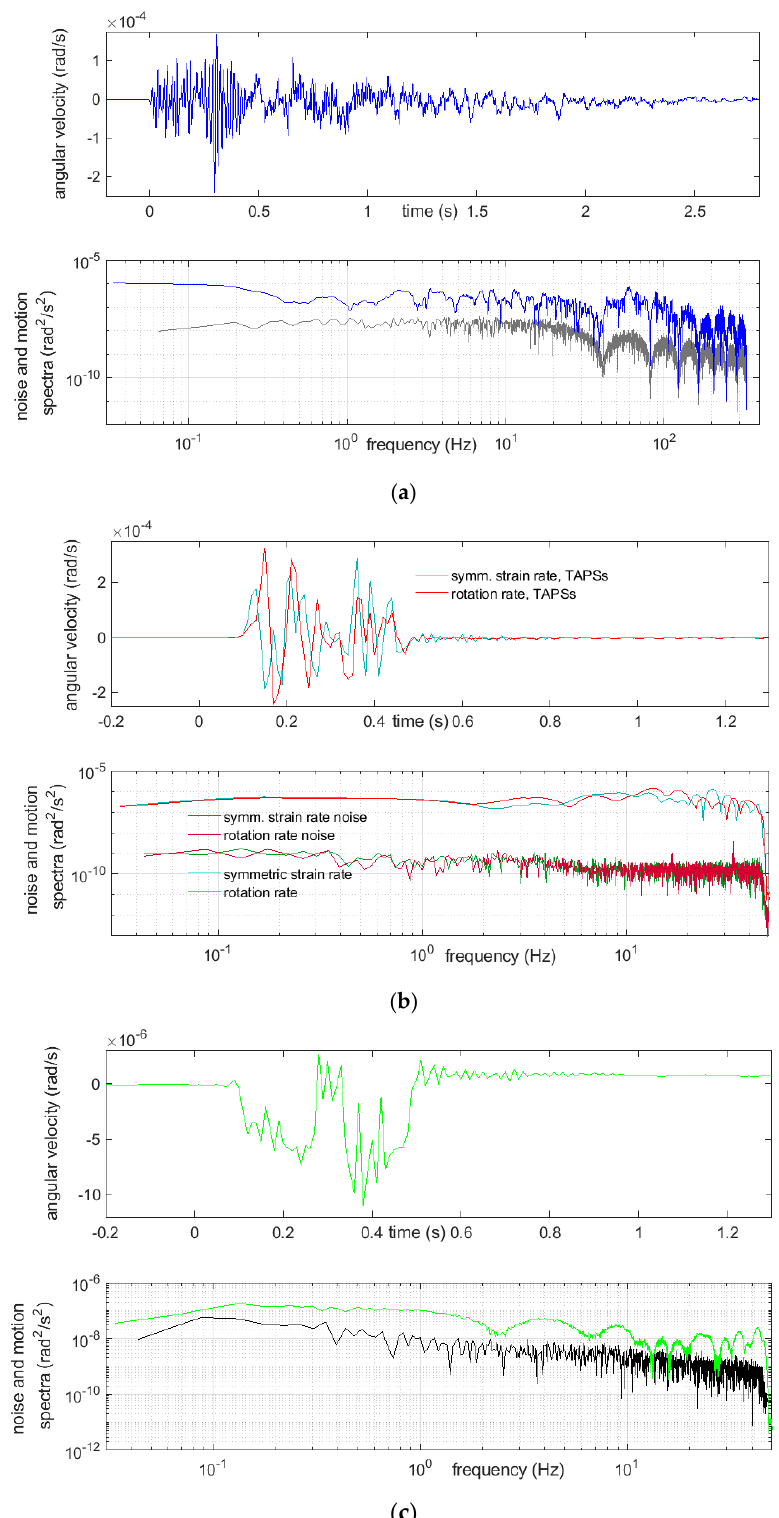
Figure 8. Recordings of a strong multiple blast, No. 39, on 19 April of 26 charges in 12 time delays and total mass of 9950 g: ( a ) from FOSREM, the rotation rate and below its spectrum (blue), together with the rotational noise spectrum (gray), ( b ) from TAPSs, the symmetric strain rate (turquoise) and rotation rate (red) and below the spectra of these motions, together with adequate noise spectra and ( c ) from the CZ sensor, the rotation rate and below its noise (green), together with the rotational noise spectrum